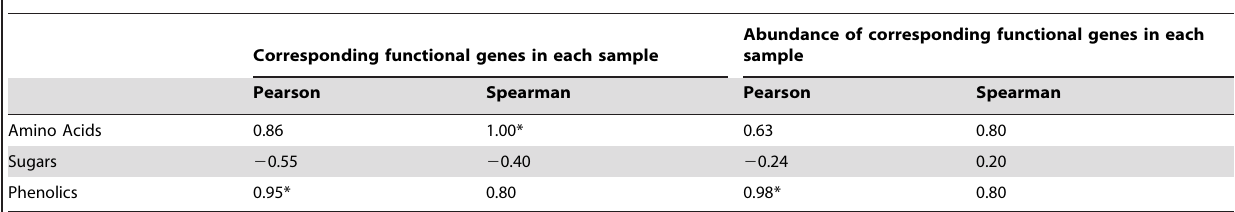
*Correlation was statistically significant (p , 0.05).